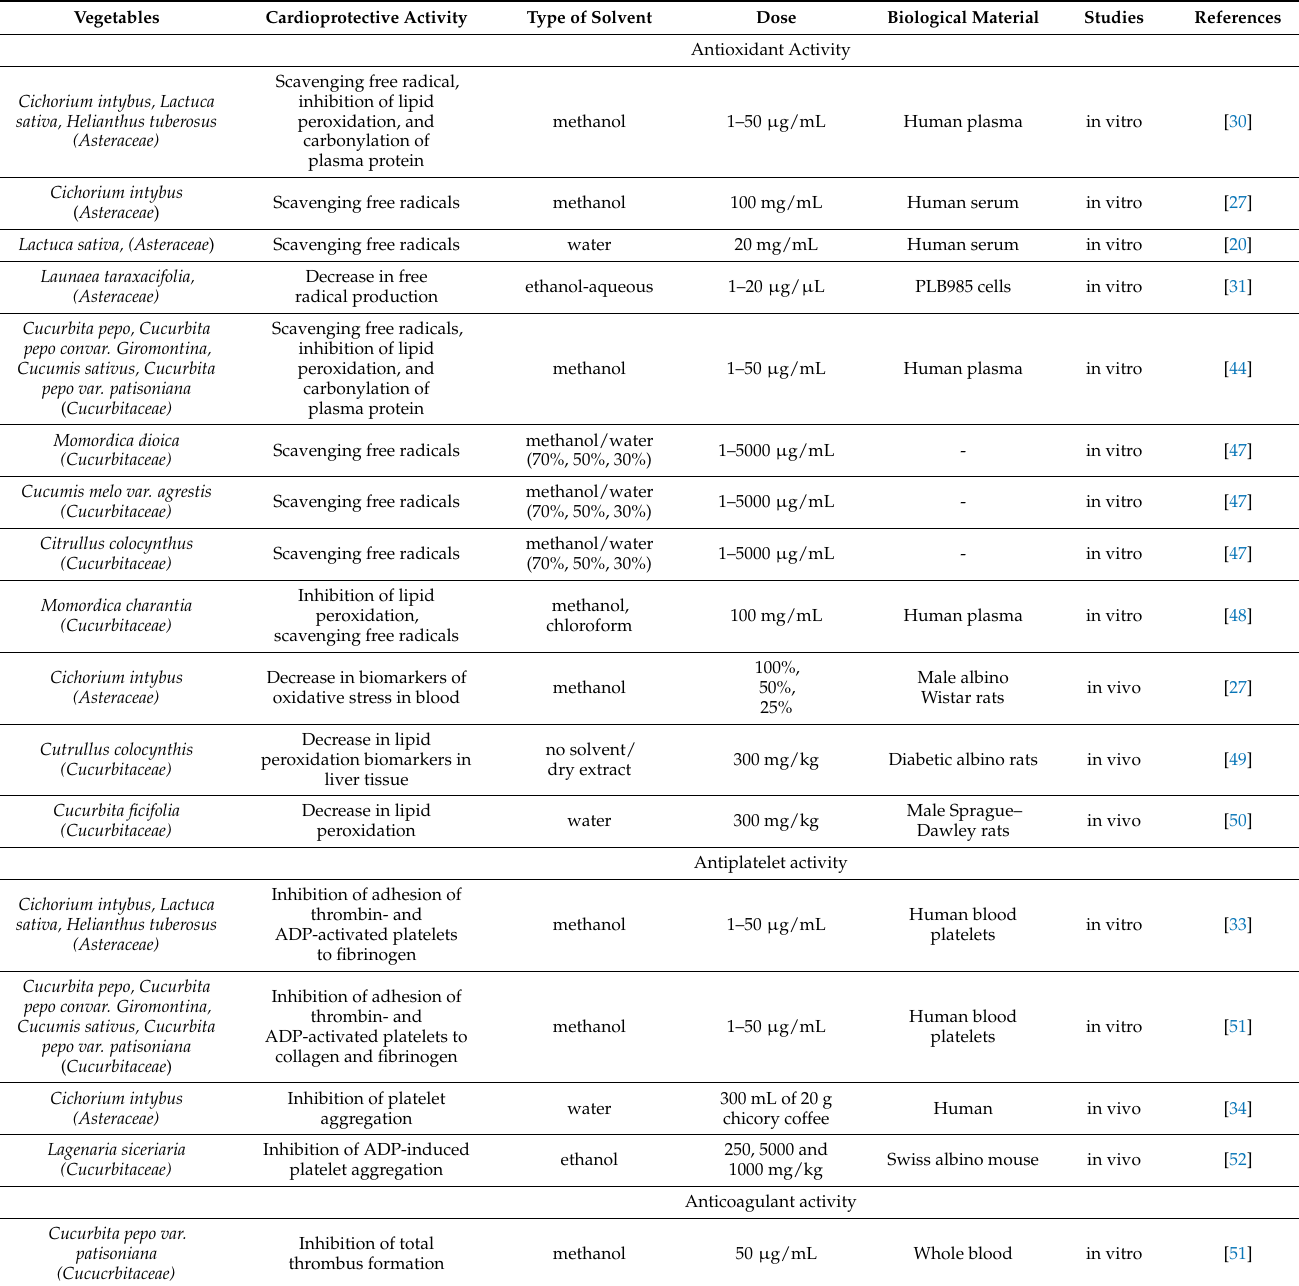
Table 1. Comparative in vitro and in vivo studies of cardioprotective activity of vegetables from Cucurbitaceae and Asteraceae